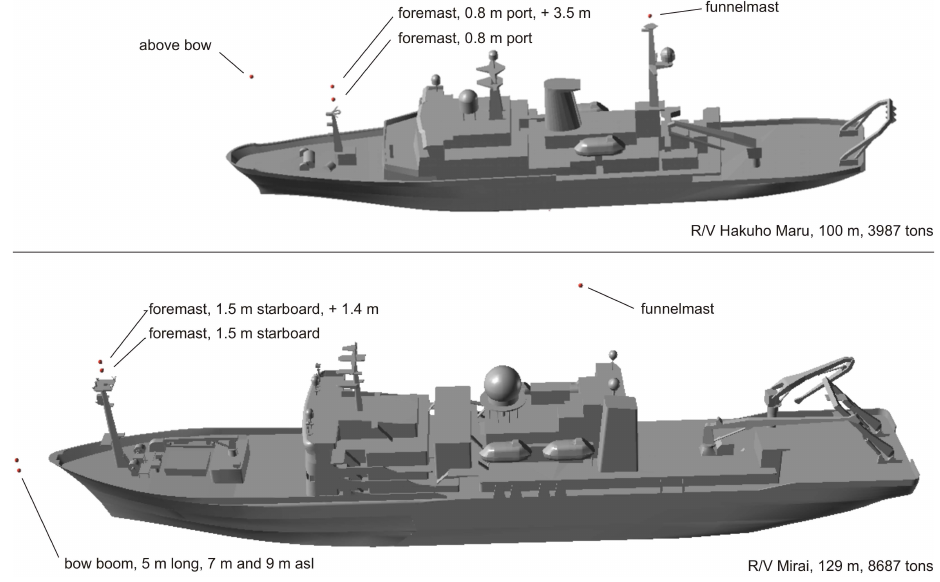
Fig. 1. Digital geometries of R/V Hakuho Maru [top] and R/V Mirai [bottom], spheres indicating various anemometer